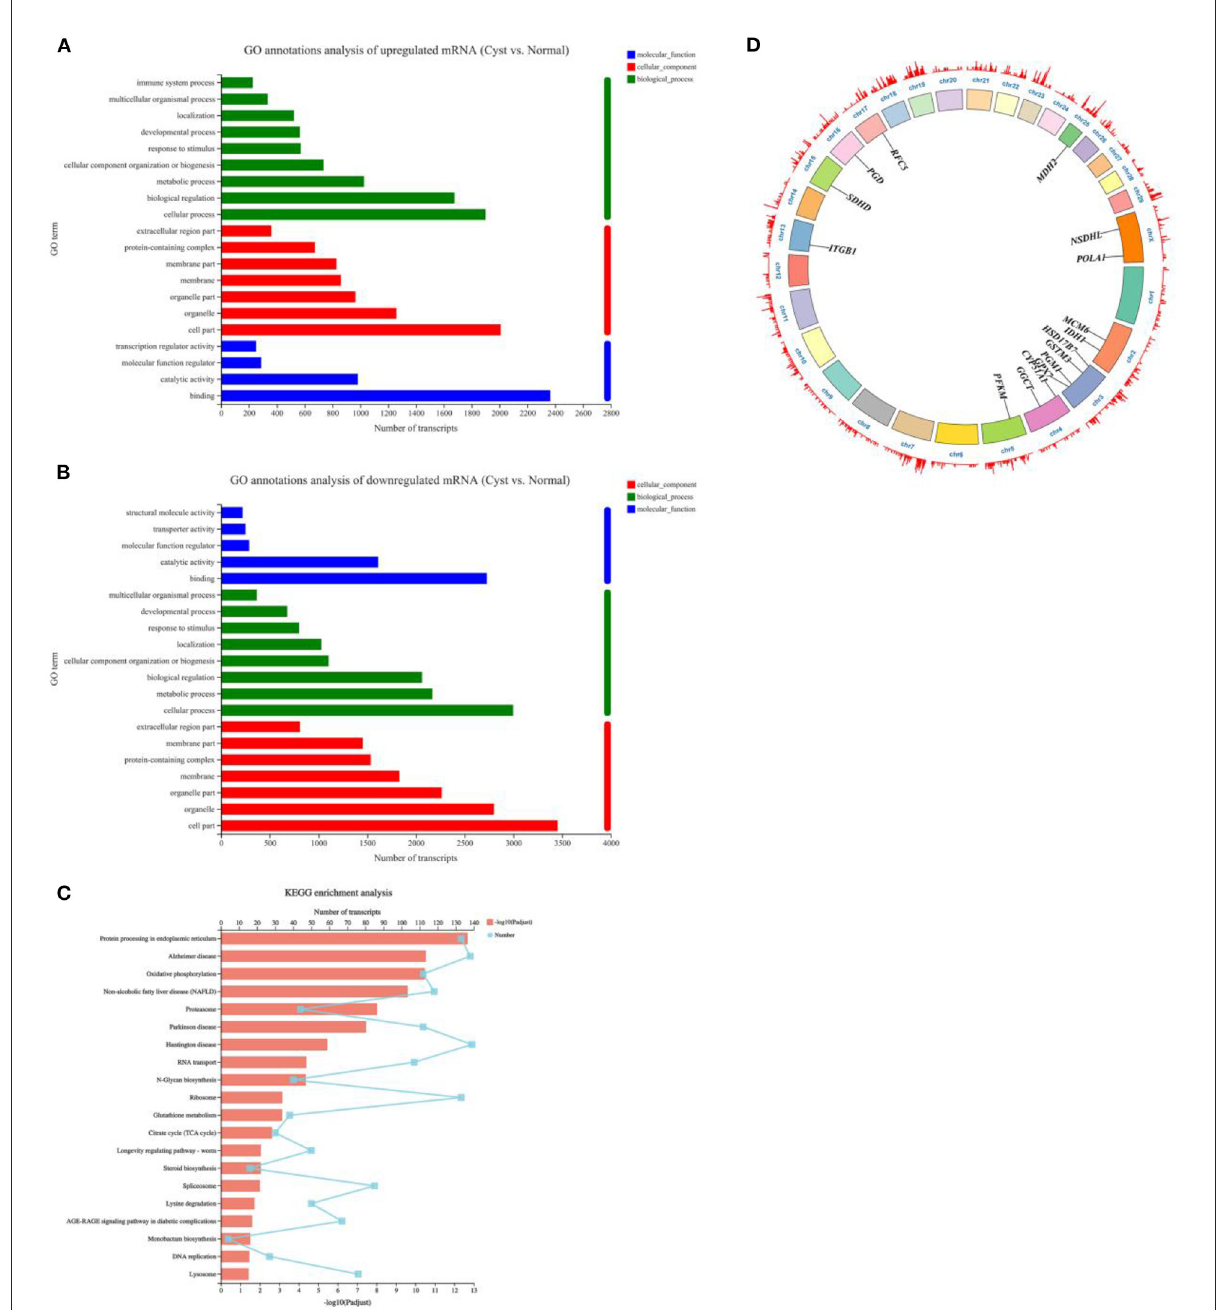
FIGURE3 Functional analysis of DE mRNAs expressed in normal and cystic follicular GCs. (A) : GO analysis of DE mRNAs upregulated in bovine cystic follicular GCs; (B) : GO analysis of DE mRNAs downregulated in bovine cystic follicular GCs. (C) KEGG analysis. (D) : Circos plot of DE mRNAs associated with steroid hormone biosynthesis and metabolic (the inner ring represents 1 to 29 bovine autosomal and X sex-chromosomes. The outer ring indicates the chromosomes gene density).